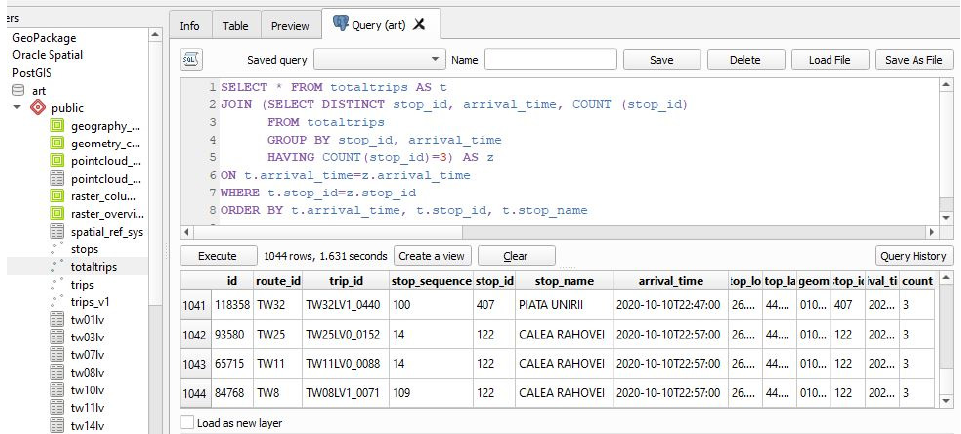
Figure 13. Example of 3 vehicles arriving at the stop_id 122 at the same time.